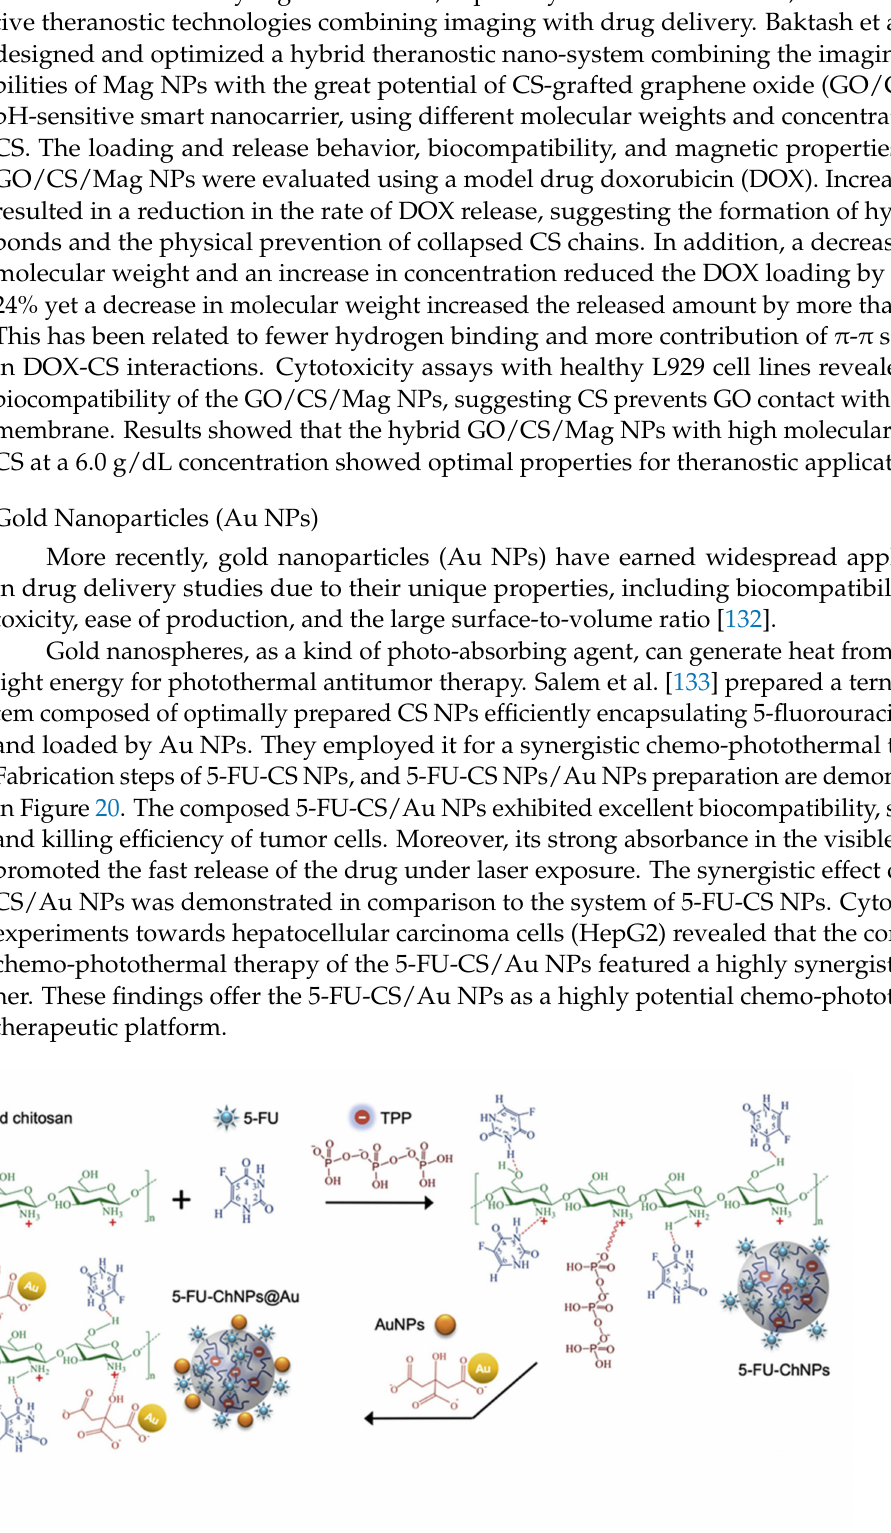
Figure 20. Fabrication steps of 5-FU-CS NPs, and 5-FU-CS NPs/Au NPs. Electrostatic interaction ( ) between positively amino groups of CS and negatively charged TPP groups is built via the ionic gelation method. The hydrogen bond interaction ( ) occurs between the hydrogen atom and a highly electronegative atom as O or N atom [133]. Reproduced with permission from Elsevier